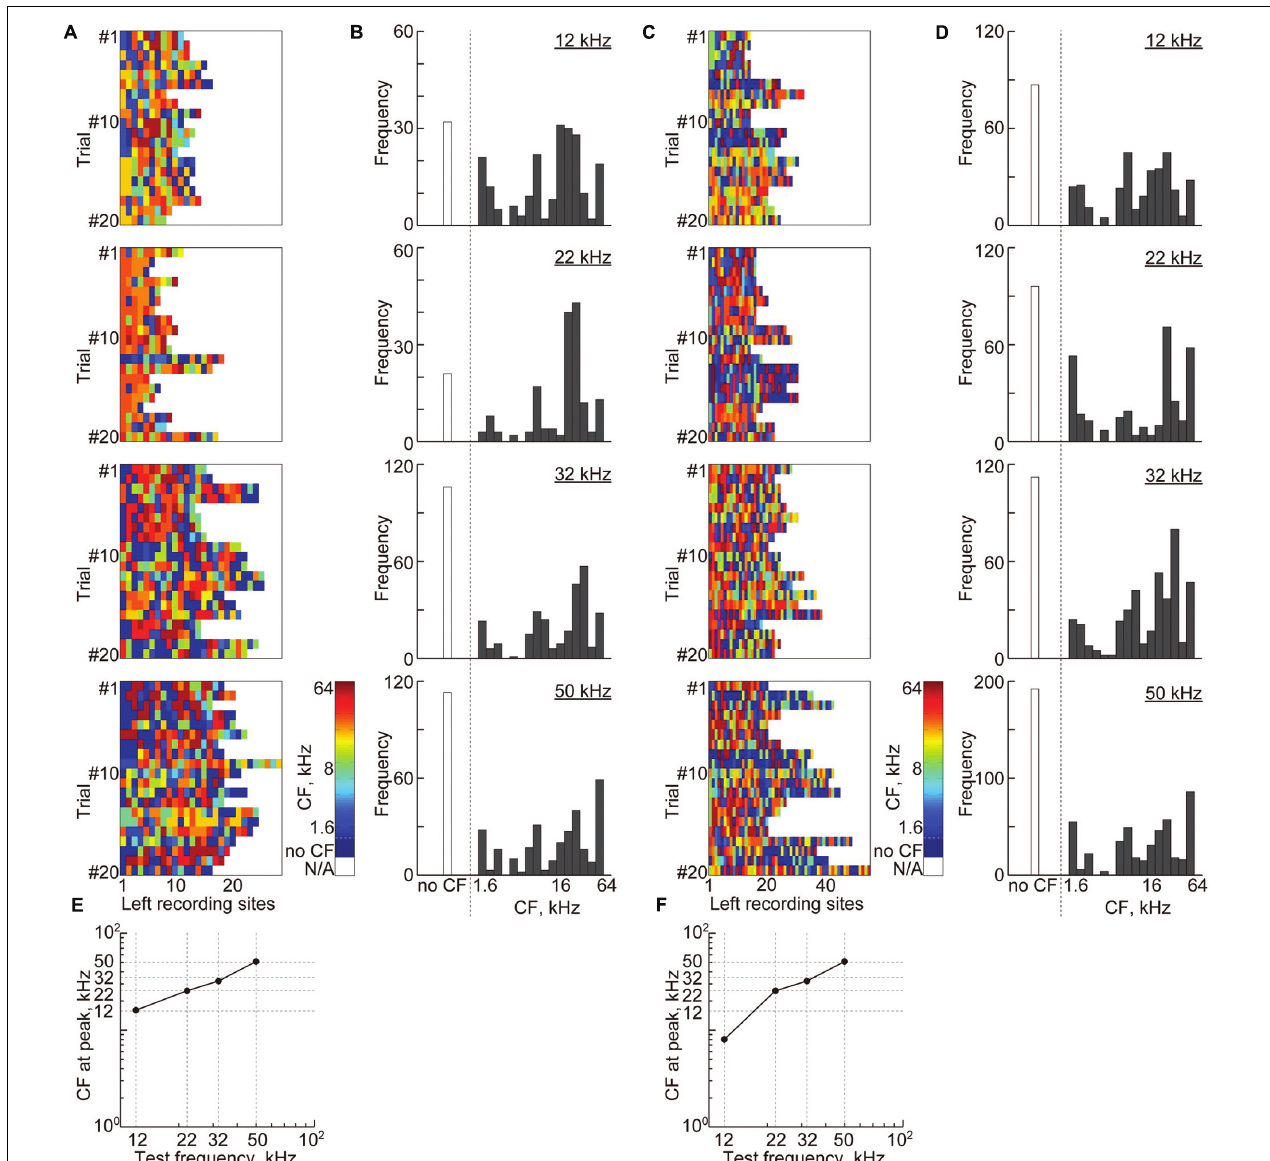
FIGURE 9 | Cortical representation of sustained activities based on characteristic frequencies. (A) Each color shows the CF at the remaining recording sites with non-zero weights in the most successful 20 discrimination trials of each test frequency from the high-gamma power. (B) The histograms of the CF shown in (A) with respect to the 18 frequencies ranging from 1.6 to 64 kHz. (C) Each color shows the CF at recording sites of the remaining features in the most successful 20 discrimination trials of each test frequency from the high-gamma PLVs. (D) The histograms of the CF shown in (C) . (E,F) The CFs at the peak of the histograms with respect to the test